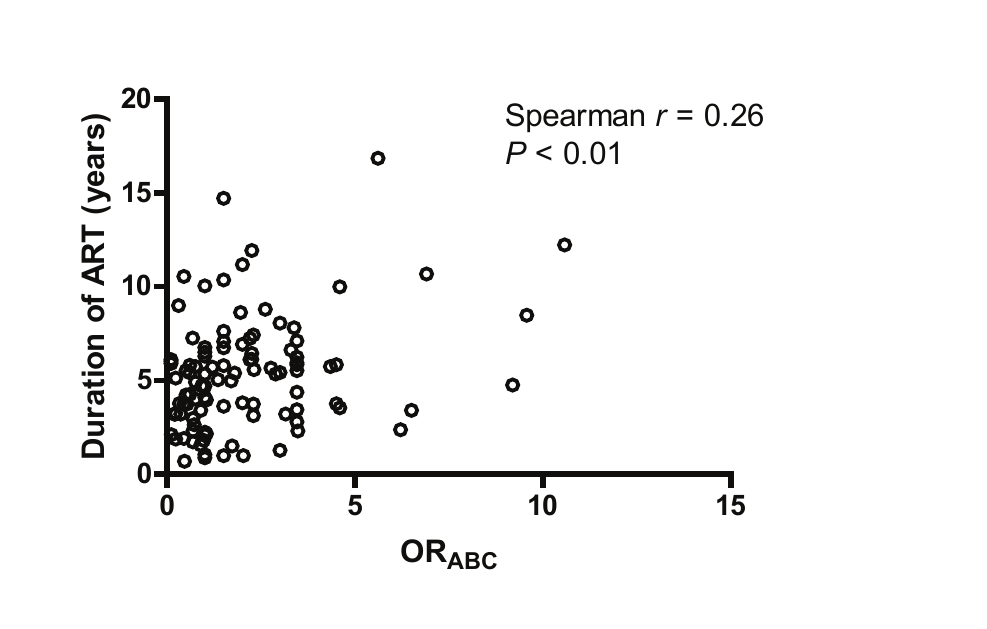
Figure 1. Correlation between OR and duration of ART. OR represents an overall assessment of ABC ABC protective status and is calculated by multiplying the ORs of HIV control of all 6 alleles at the A, B, and C loci. A lower OR is associated with greater control of HIV ABC